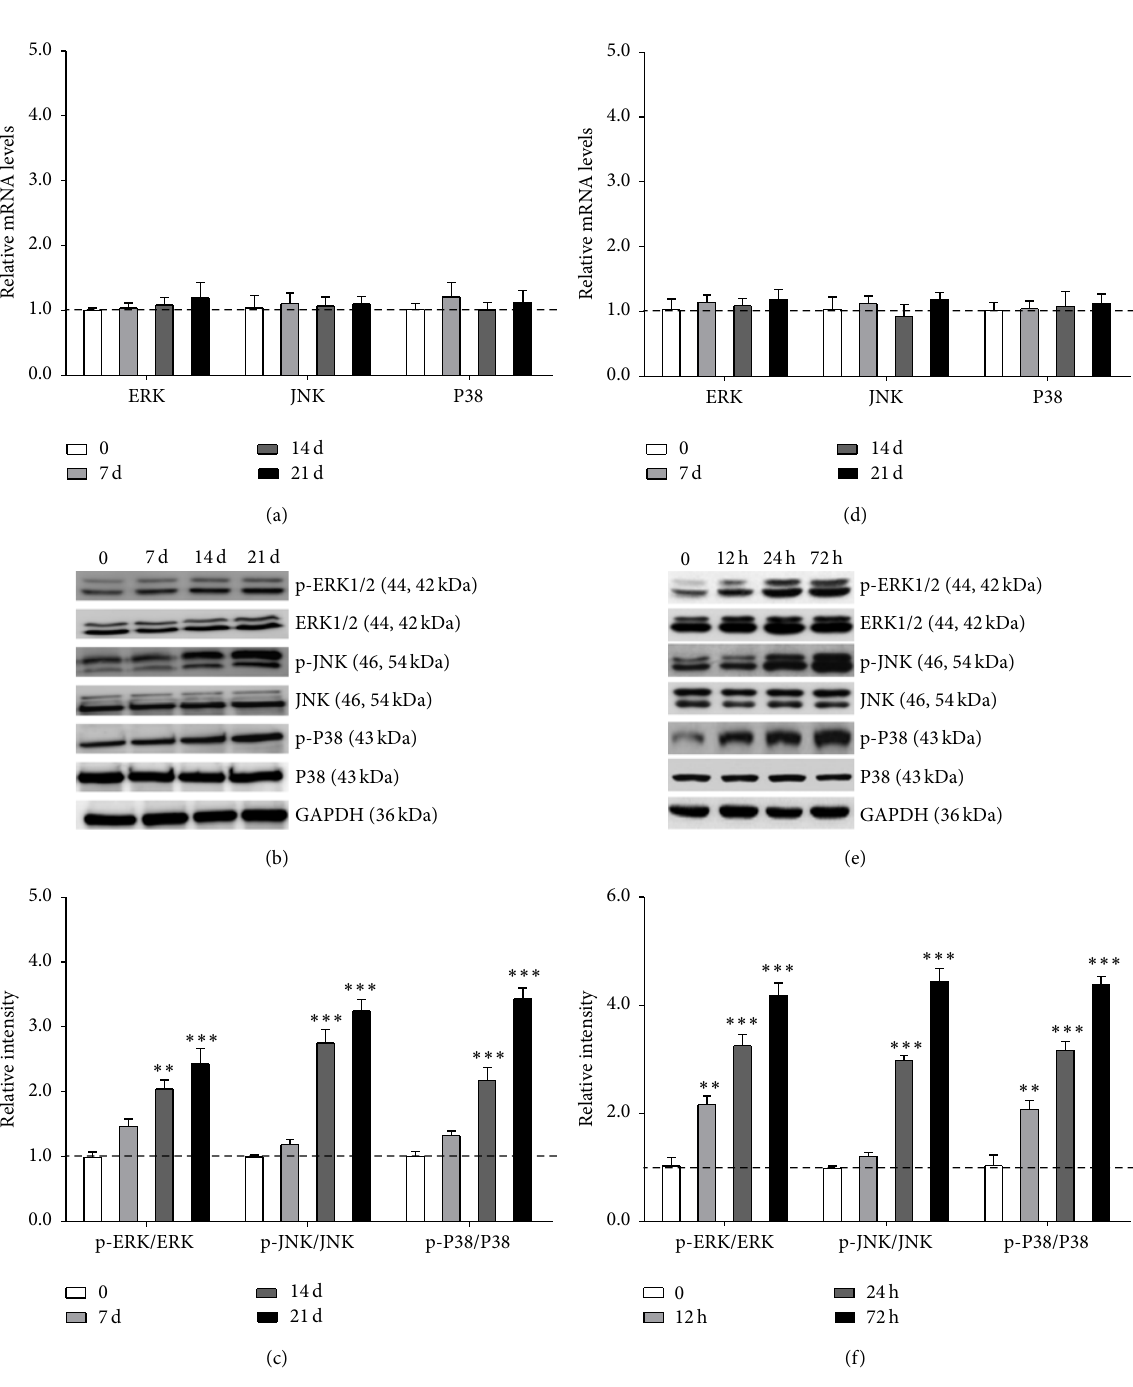
Figure 5: ET-1 promoted differentiation of PDLSCs through MAPKs pathway. RT-PCR showed no difference in ERK, JNK, and p38 after ET-1 treatment ((a) and (d)). Western Blot analysis indicated that exposure of the cells to ET-1 effectively increased the levels of phosphor-ERK1/2, phosphor-JNK, and phosphor-p38 without altering the total amounts of these proteins ((b), (c), (e), and (f)). Each bar represents the mean ± standard deviation ( 𝑛 = 3 ). ∗ 𝑃 < 0.05 ; ∗∗ 𝑃 < 0.01 ; ∗∗∗ 𝑃 < 0.001